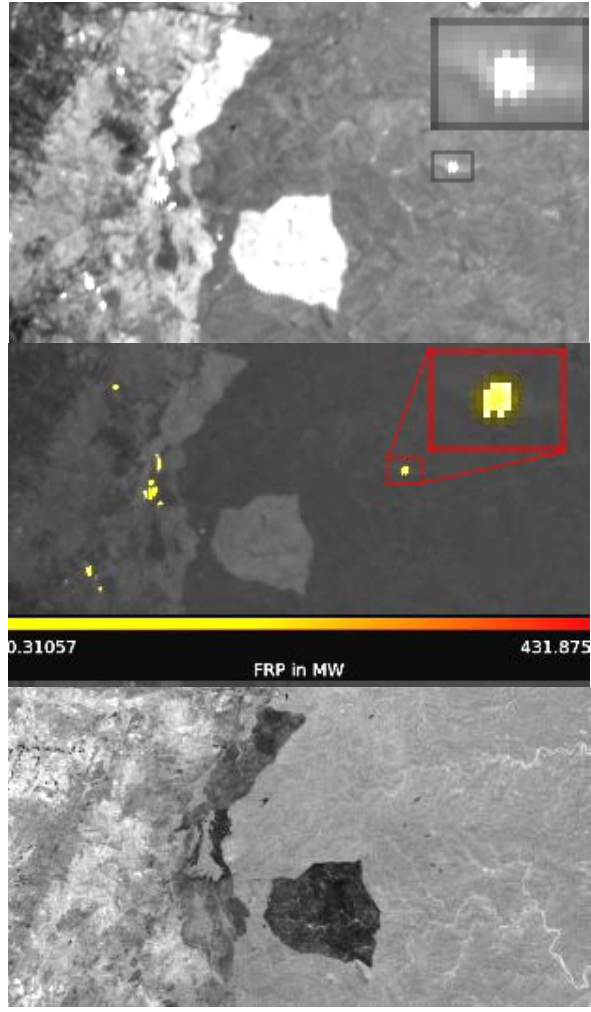
Figure 6: Fire experiment in open savannah in Kruger National Park, Republic of South Africa (26th Aug. 2014). Top: MWIR channel, Middle: FRP; Bottom NIR channel Clearly visible in the right part of Figure 6 is the area of the Kruger National Park as a relative homogeneous area. Outside farm land and used for pasture in order to burn old